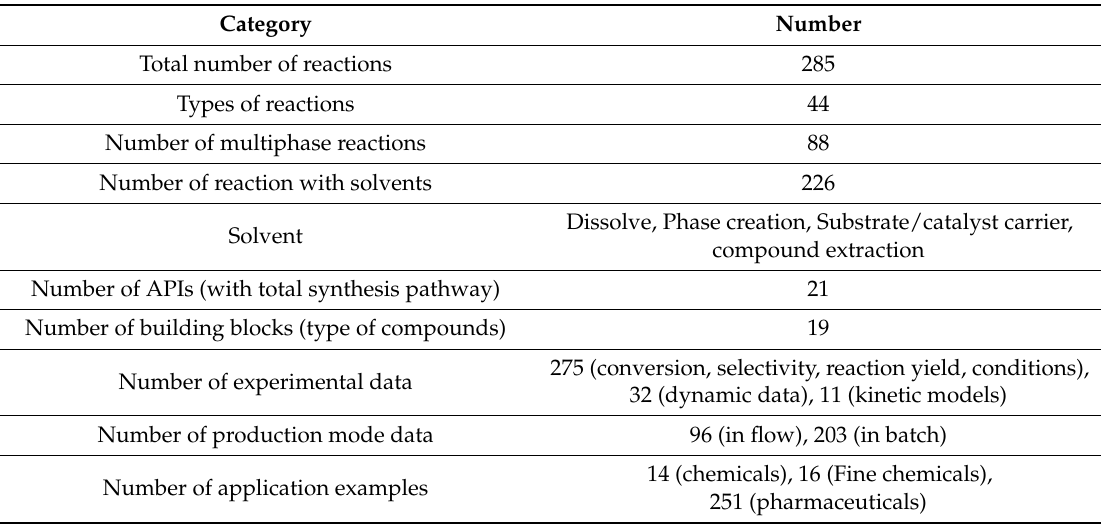
Table 5. Summary of the information included in the database.